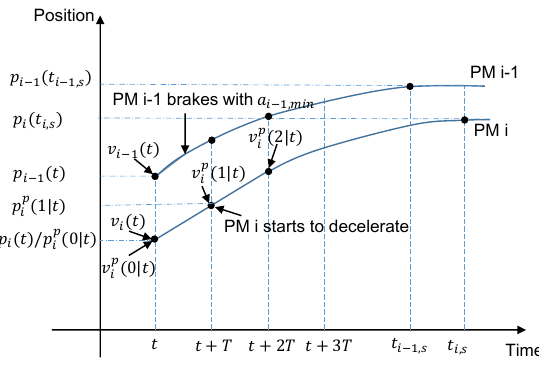
Figure 3. Safety